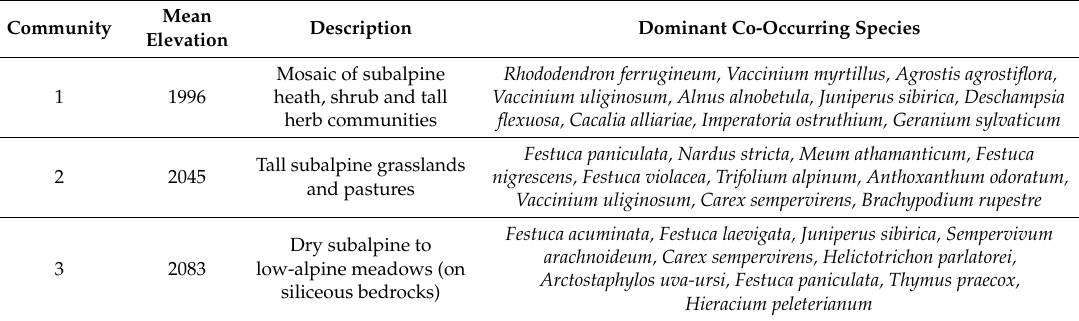
Table 2. Dominant co-occurring species and mean elevation (m a.s.l.) and habitat descriptions for twelve plant communities identified by clustering analysis.